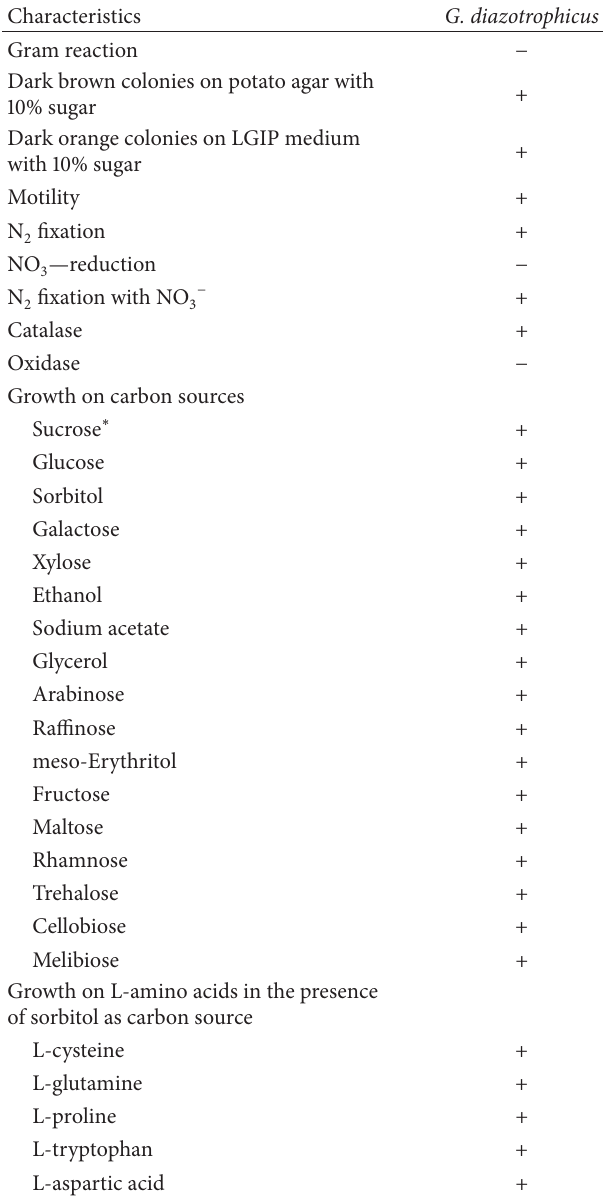
Table 2: General characteristics of Gluconacetobacter diazotrophi-